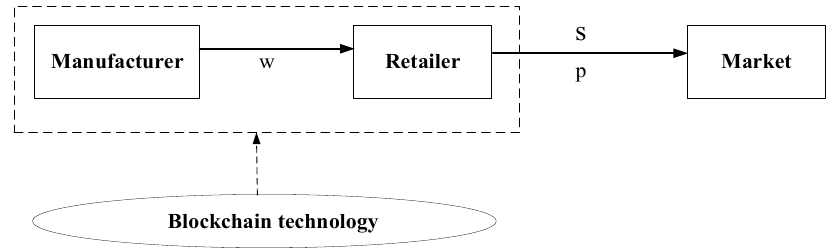
Figure 1. Supply chain structures. Table 2. Notations.